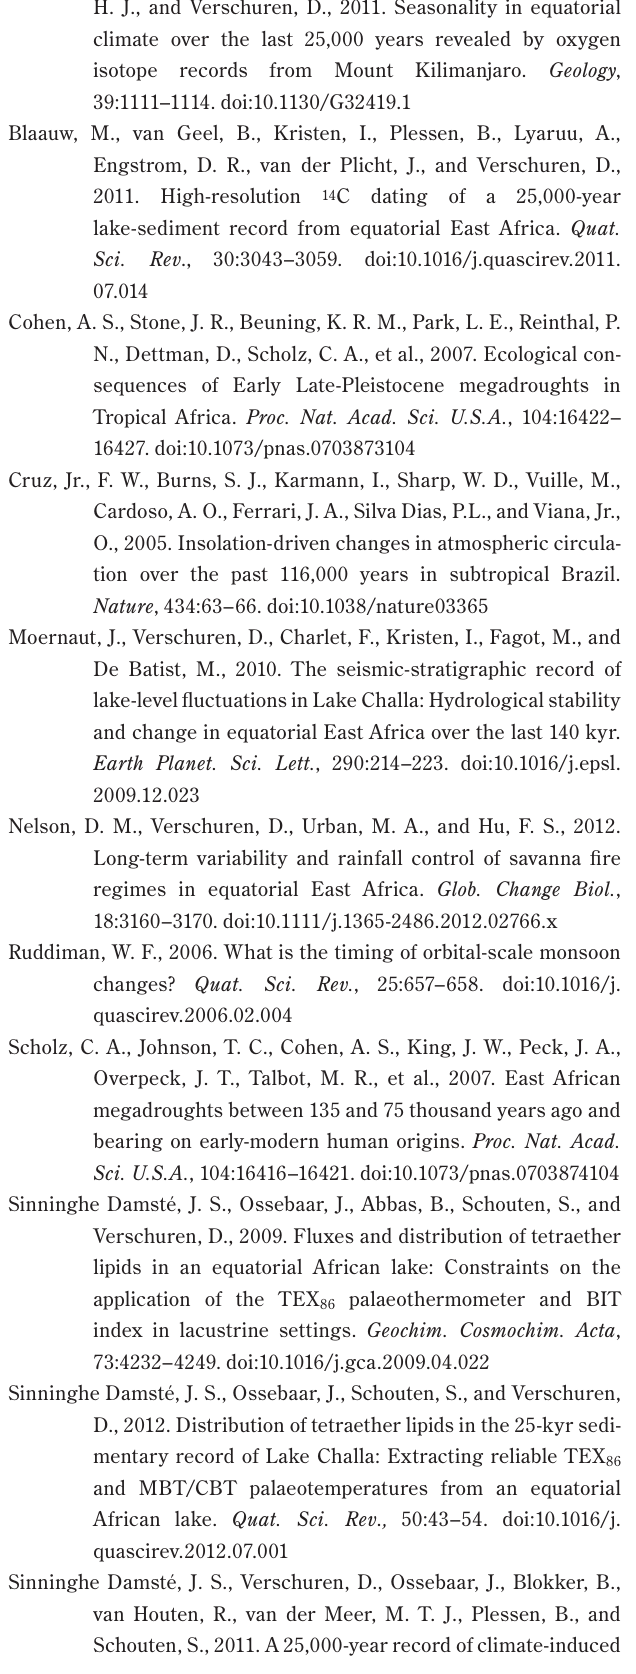
Fig. 2: National Museums of